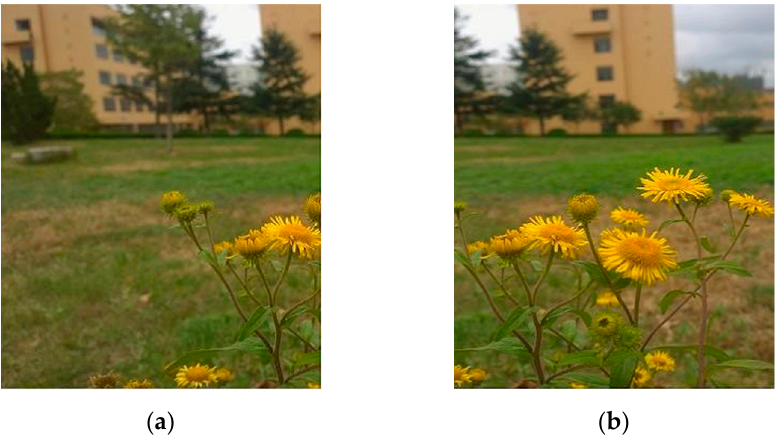
Table 1. Three image quality indexes of T1 and T2. Figure 4. The original images for T2: ( a ) Reference image; ( b ) Be-registered image.